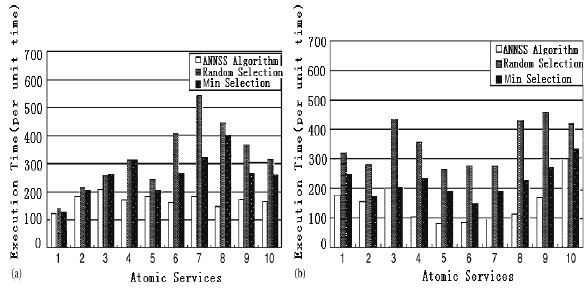
Fig. 3. Architecture of ISSPS.